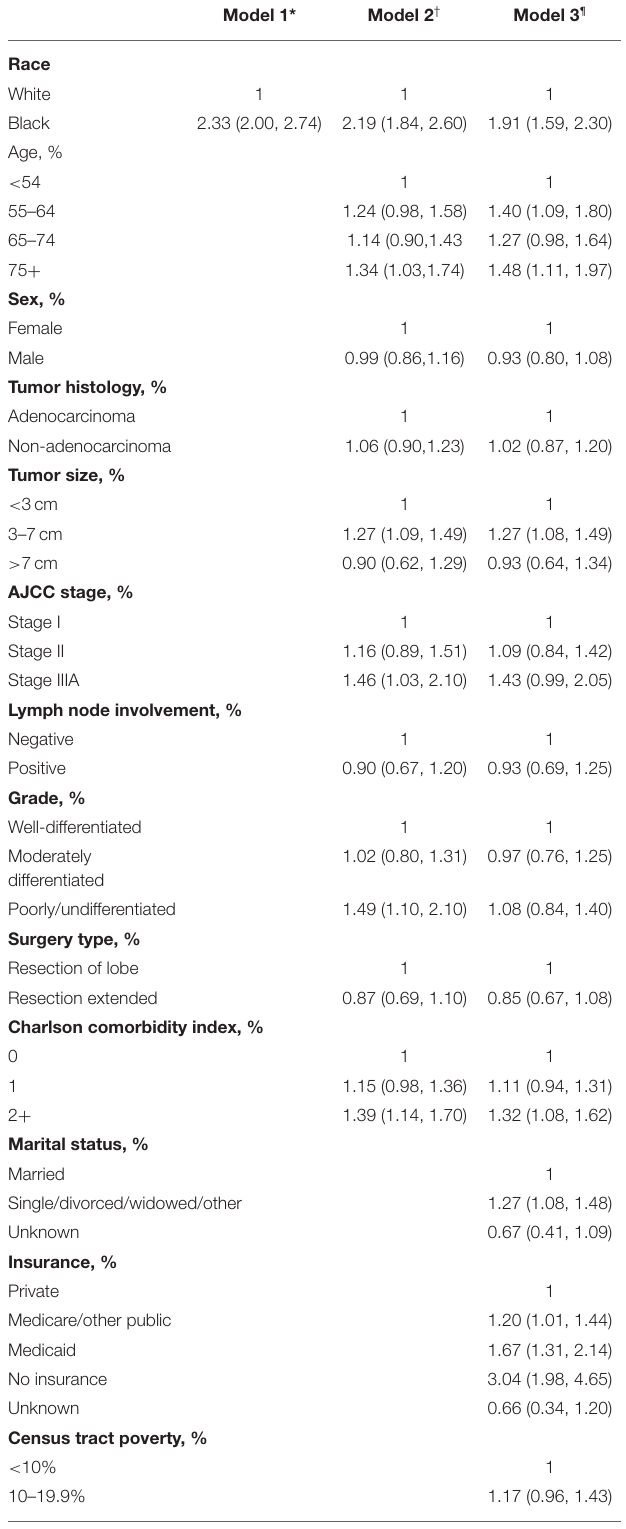
TABLE 2 | Odds ratio (95% confidence interval) of receiving surgery 6 weeks or later after diagnosis for non-small cell lung cancer patients. Model